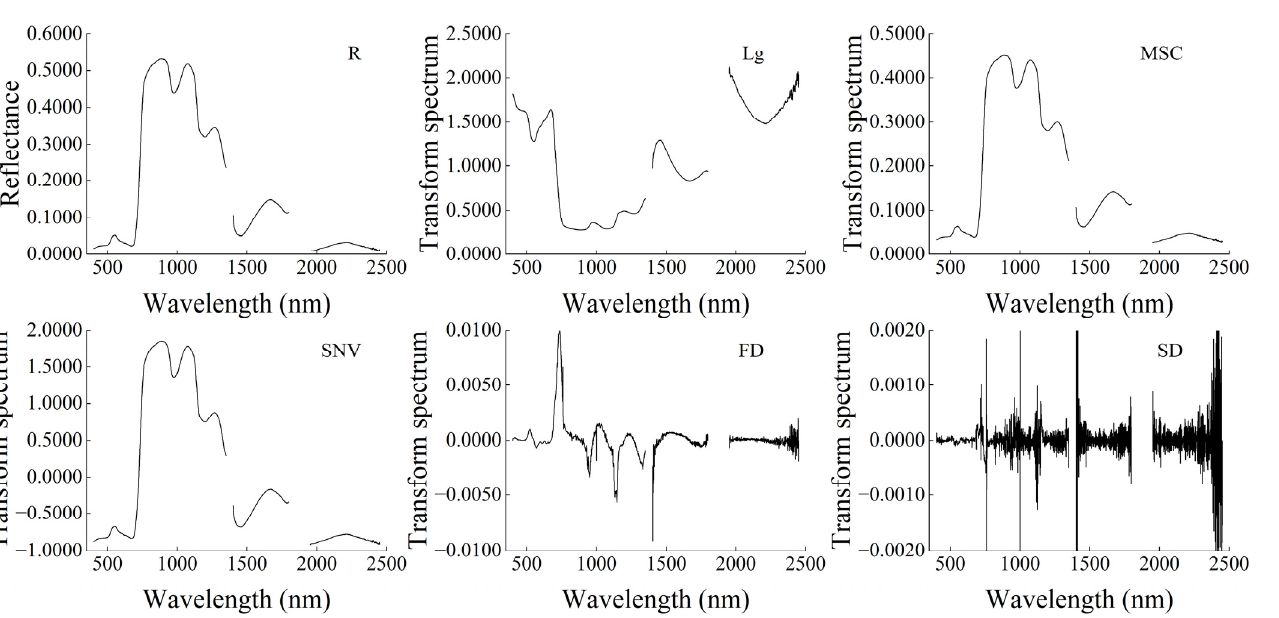
Figure 3. Original spectrum and preprocessing spectra. Note: R, Lg, MSC, SNV, FD, and SD are original spectrum, reciprocal logarithm transformation spectrum, multiple scattering correction transformation spectrum, standardized normal variate transformation spectrum, first derivative transformation spectrum, and second derivative transformation spectrum, respectively. The same below.